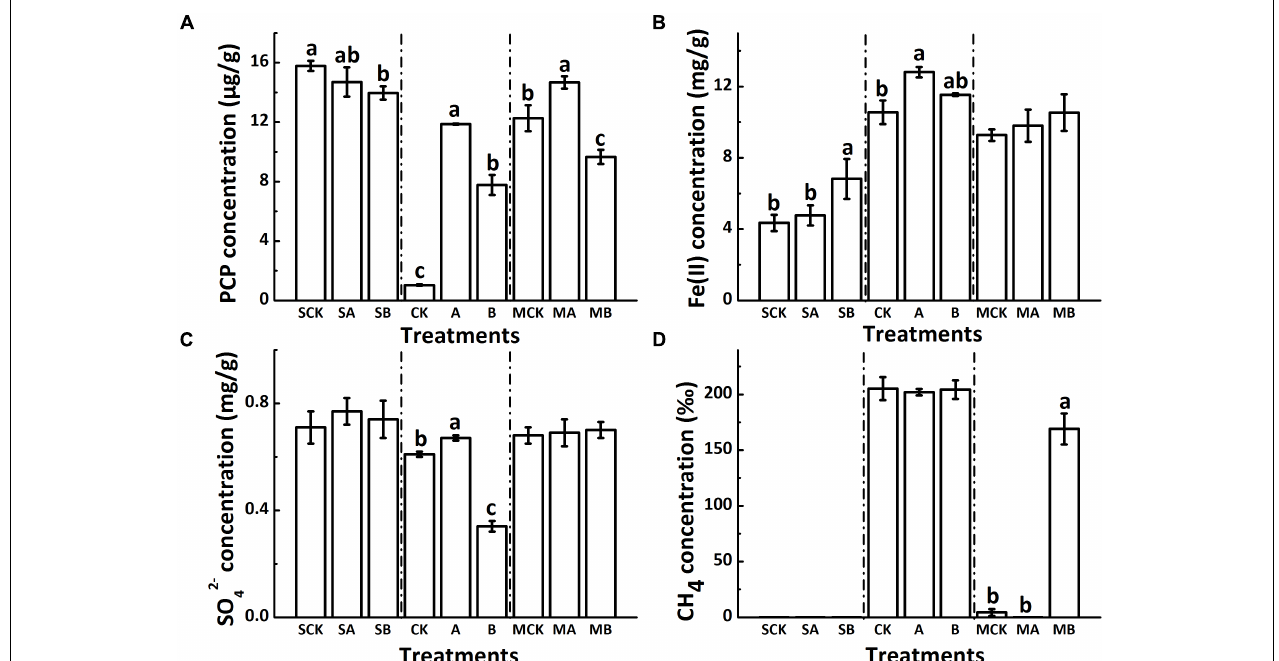
FIGURE 1 | Different soil redox processes at 120 days as shown by the concentration of PCP, Fe(II), SO 42 − and CH 4 (A–D) . CK: Soil + none; A: Soil + AQDS; B: Soil + 1% biochar; the prefix “S”: sterilized abiotic treatment group; the prefix “M”: unsterilized biotic molybdate treatment group. Only significant differences ( p < 0.05) were shown by the letter (a, ab, b, c) in lowercase on the top of data column.